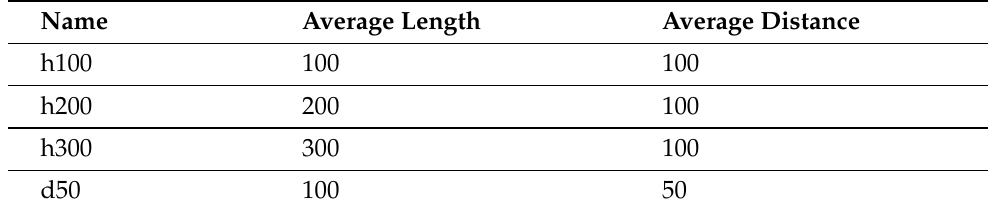
Table 1. Parameters of the generated data